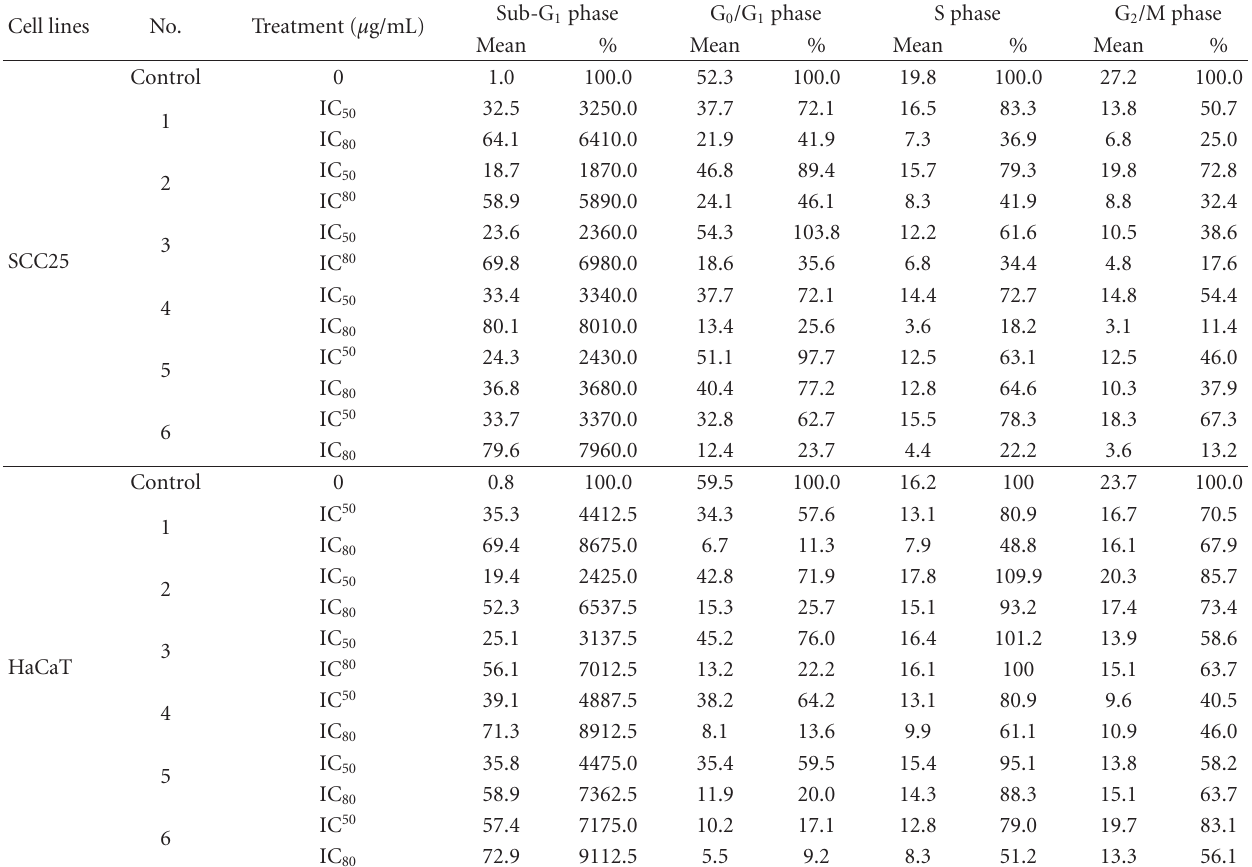
Table 3: The changes of cell cycle distribution of the genus Sinularia extracts in SCC25 and HaCaT cells. Cell lines